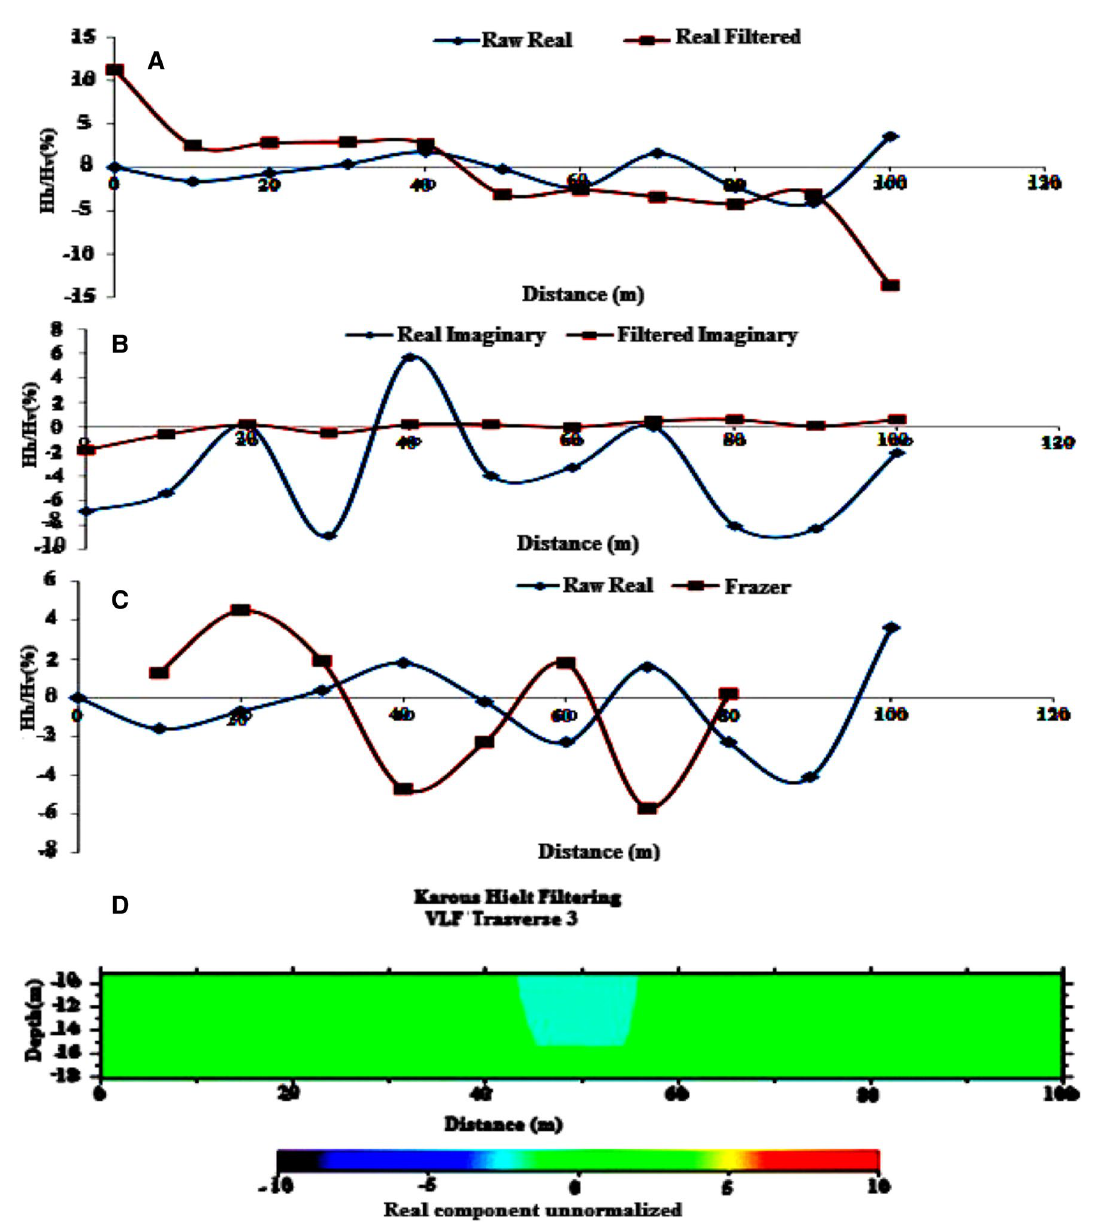
Fig. 4 VLF-EM profile 2 along north–south direction a Plot of raw and filtered imaginary against distance b Plot of imaginary raw and filtered against distance c Frazer filtering against distance d Pseudosection of the inverted real component,